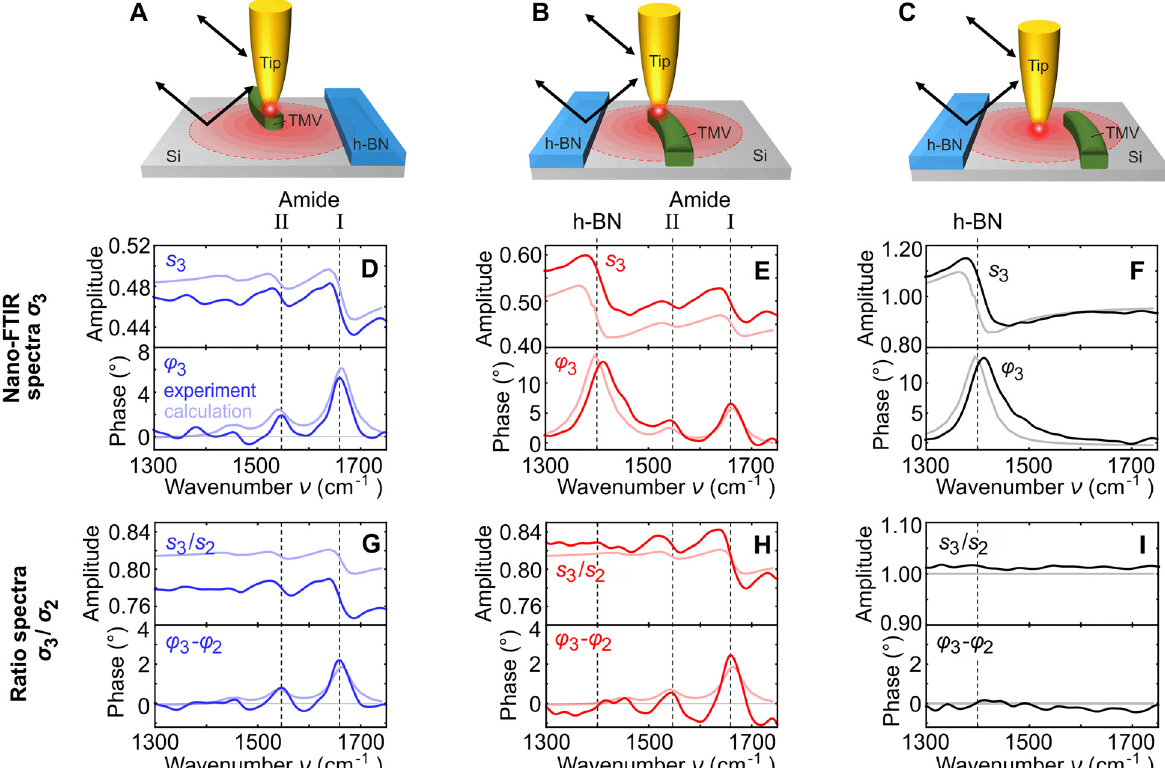
Figure 6: Comparison of experimental nano-FTIR spectra and their ratio of a single tobacco-mosaic-virus. (A – C) Illustration of nano-FTIR experiments with a TMV located at a distance of x ≈ 5 μ m from a 150 nm-thick h-BN fl ake, both located on a Si substrate. (A)The tipis locatedona TMVandilluminateddirectlyandvia re fl ectionat thebareSisubstrate,(B)sameaspanel (A)but thetipis illuminatedviare fl ectionattheh-BN fl ake,(C)thetipislocatednexttoaTMVonSiandilluminatedviare fl ectionattheh-BN fl ake.(D – F)nano- FTIR amplitude s 3 (upper panels) and phase spectra φ (lower panels) corresponding to panels A – C. Phase spectra φ are baseline-corrected 3 3 − φ (see Methods section). (G – I) Amplitude ratio (upper panels) and phase difference spectra (lower panels), s 3 / s 2 and φ . (D – I) All spectra 3 2 were normalized to a reference nano-FTIR spectrum recorded on the Si substrate far away from TMV and h-BN. Vertical dashed lines at ν = 1425cm − 1 , 1545cm − 1 and 1660cm − 1 indicate the spectral positions of the h-BN TO phonon, amide II and amide I bands of the TMV, respectively. Dark colored curves show experimental spectra, light colored curves show calculated spectra. Experiments were performed using PtIr tips (Neaspec nano-FTIR probe) with an apex radius R = 40 nm and tapping amplitude A = 30